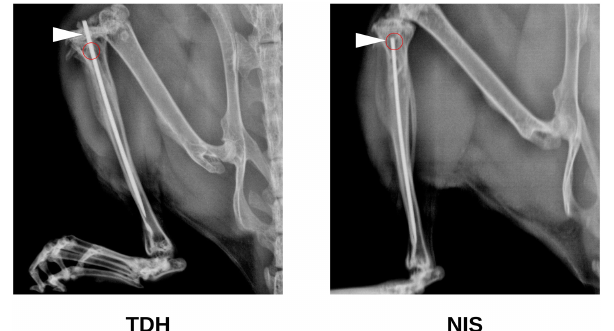
Figure 2. Study 1B. X-ray images illustrating the lack of disruption of the tibial condyle (white arrows) by pin insertion through the de- fect site (red circles) featured in the NIS model. This latter method of insertion minimized retrograde movement of the pin at the knee.